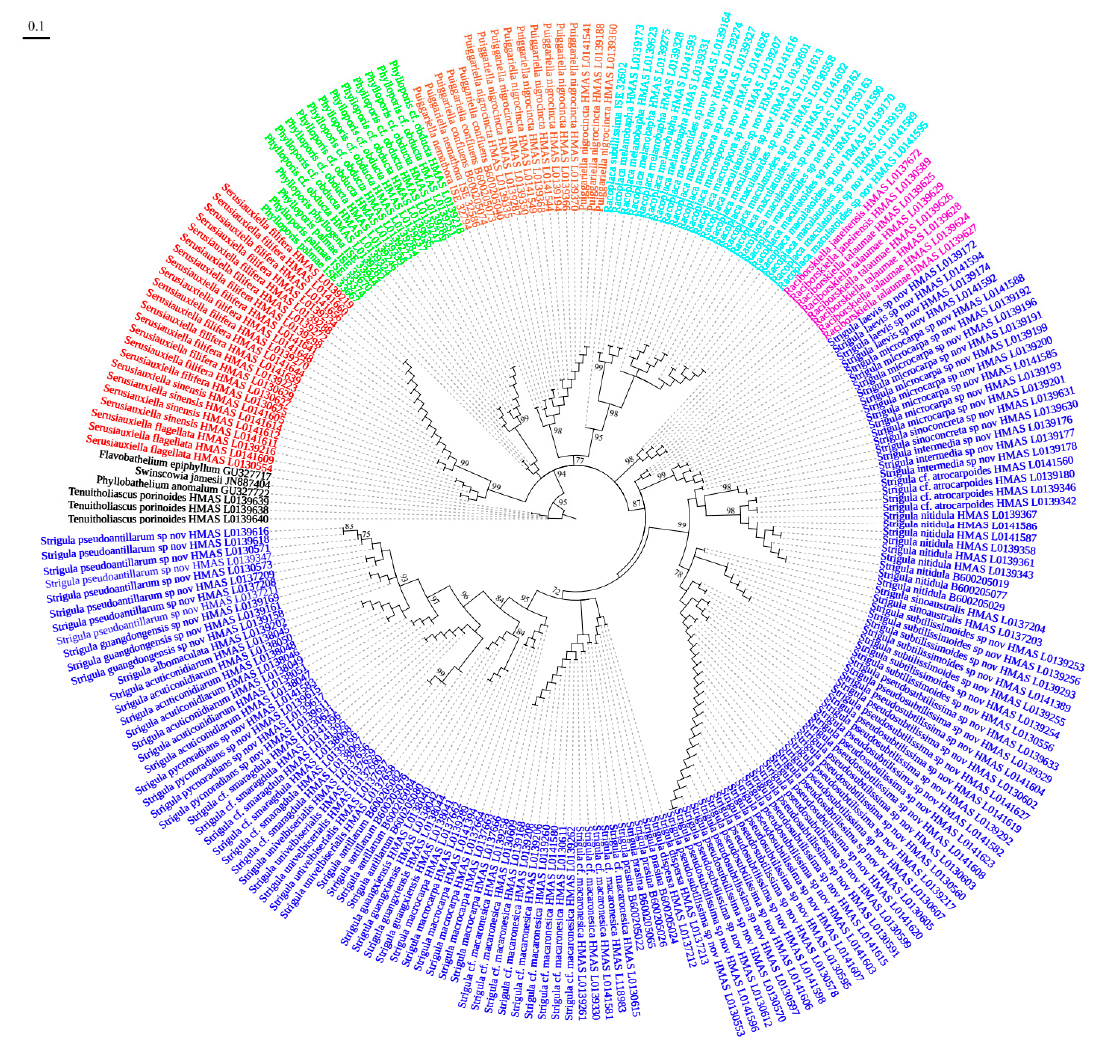
Figure 3. The coalescent ‐ based species tree by ASTRAL.